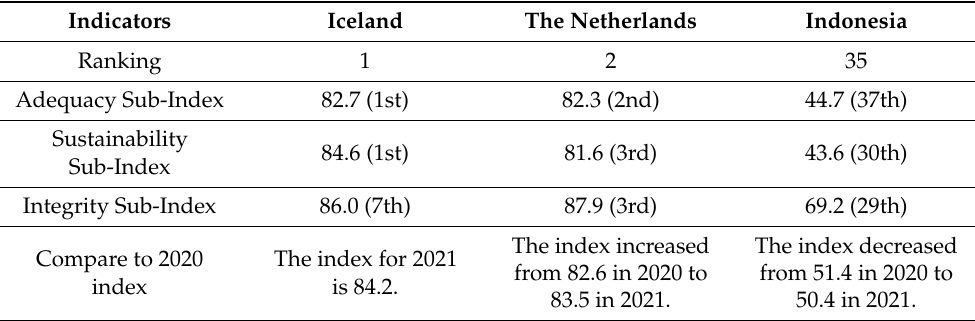
Table 1. Comparison of the Index 2021 between Indonesia, Iceland, and the Netherlands. Indicators Iceland The Netherlands